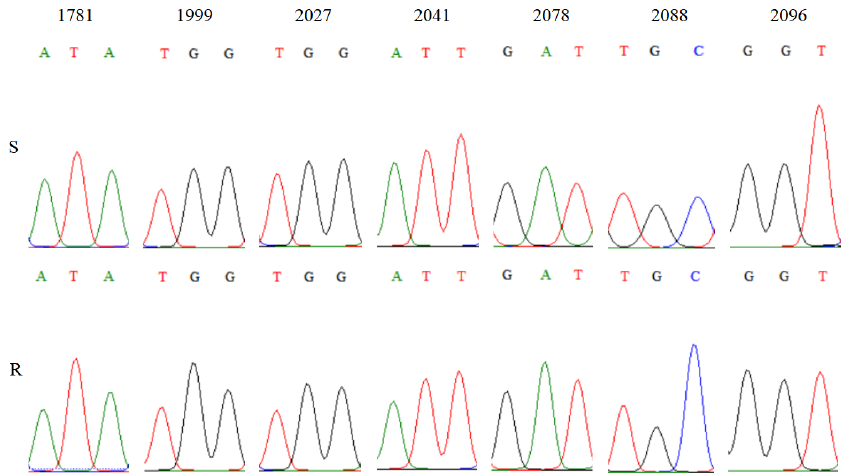
Figure 3. Acetyl coenzyme A carboxylase (ACCase) sequence in resistant (R) and susceptible (S) Alopecurus japonicus populations. Lines indicated alignment of partial amino acid sequences of plas- tidic ACCases from various weed species that are sensitive to ACCase herbicides.